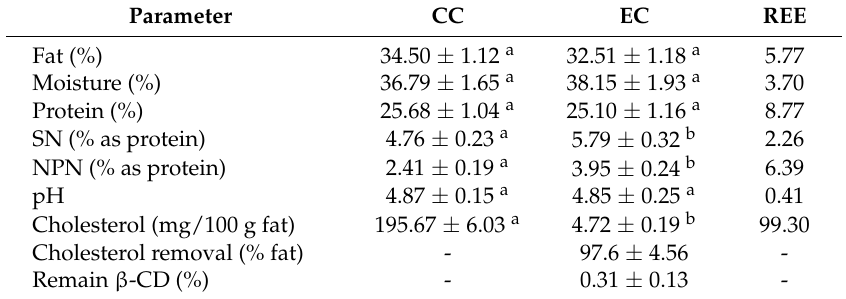
Table 1. Gross composition of the control and the experimental Manchego cheese by the effect of the β -CD. Parameter CC EC Fat (%) 34.50 ± 1.12 a